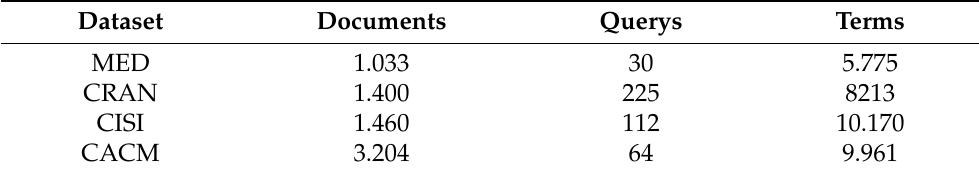
Table 1. Basic statistics of each dataset used in our